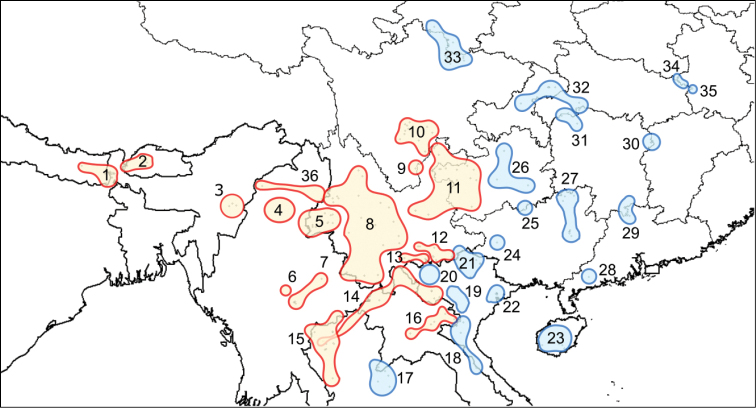
Current distribution map of the genus Tylototriton, from South and Central China, to northern Vietnam, Laos, Thailand, Myanmar, India, Bhutan and Nepal (Hernandez 2016; Qian et al. 2017; Grismer et al. 2018; Wang et al. 2018; Grismer et al. 2019; Hernandez et al. 2019; Zaw et al. 2019). In red the distribution areas belonging to the subgenus Tylototriton, and in blue the distribution areas belonging to the sub–genus Yaotriton (Dubois and Raffaëlli 2009). The numerical identification corresponds to the different species and undescribed taxa as follow: 1T.
himalayanus2T.
cf.
himalayanus (Bhutan) 3T.
cf.
verrucosus (Manipur) 4T.
kachinorum5T.
verrucosus6T.
ngarsuensis7T.
shanorum8T.
shanjing9T.
pseudoverrucosus10T.
taliangensis11T.
kweichowensis12T.
yangi13T.
pulcherrimus14T.
anguliceps15T.
uyenoi16T.
podichthys17T.
panhai18T.
notialis19Tylototriton taxon 2, this study 20Tylototriton taxon 3, this study 21T.
ziegleri22T.
vietnamensis23T.
hainanensis24T.
cf.
hainanensis (Baise) 25T.
cf.
wenxianensis (Libo) 26T.
cf.
wenxianensis (Guizhou) 27T.
asperrimus28T.
cf.
asperrimus (Guangdong) 29T.
lizhengchangi30T.
liuyangensis31T.
broadoridgus32T.
cf.
wenxianensis (Chongquing and Hubei) 33T.
wenxianensis34T.
dabienicus35T.
anhuiensis and 36T.
panwaensis.